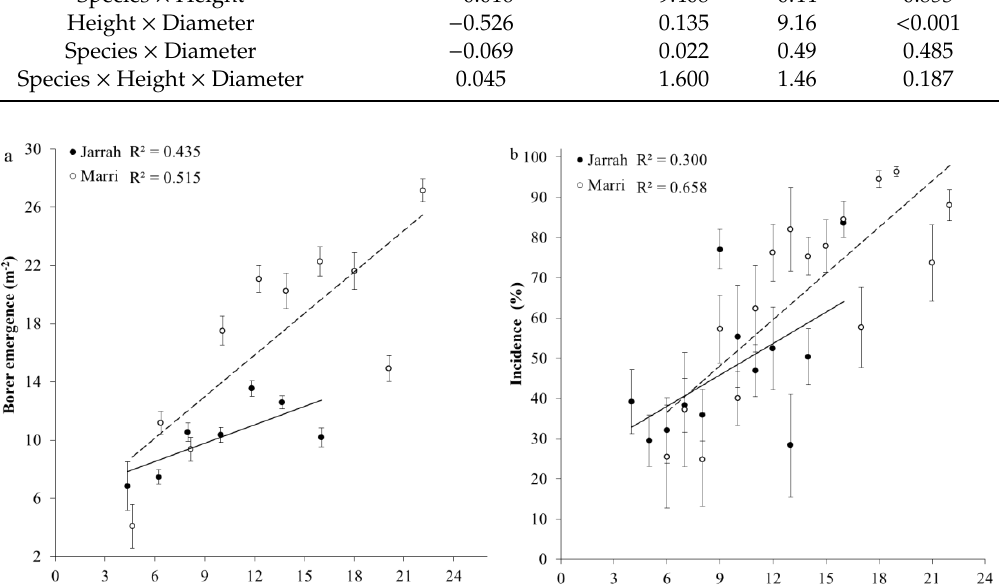
Figure 3. Relationship between mean ( ± SEM) ( a ) density of borer emergence (m − 2 ) and ( b ) incidence of larval galleries (%) of the Australian eucalyptus longhorned borer Phoracantha semipunctata and bark thickness for jarrah ( Eucalyptus marginata ●) ( n = 38) and marri ( Corymbia calophylla ○ ) ( n = 39) trees in the Northern Jarrah Forest (NJF), Southwestern Australia. Data are presented within 2-mm bark thickness intervals.